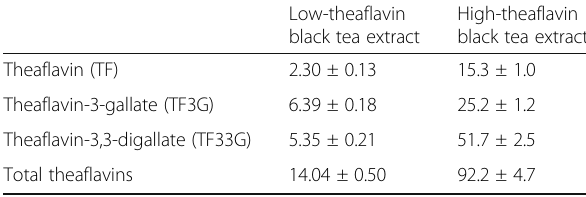
Table 3 Theaflavin content of the two black tea extracts evaluated in the present study, determined by HPLC analysis Low-theaflavin black tea extract